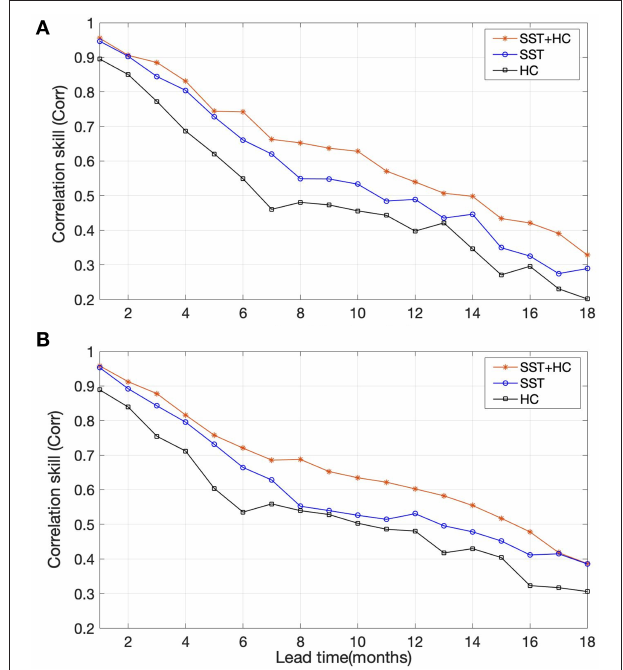
FIGURE 9 | The Corr between predicted values and actual values with different input predictors based on (A) CNN model, (B) MS-CNN model. The red line shows SST and heat content (HC) were all used as input predictors. The blue line shows only SST was used as input predictors. The black line shows only HC was used as input